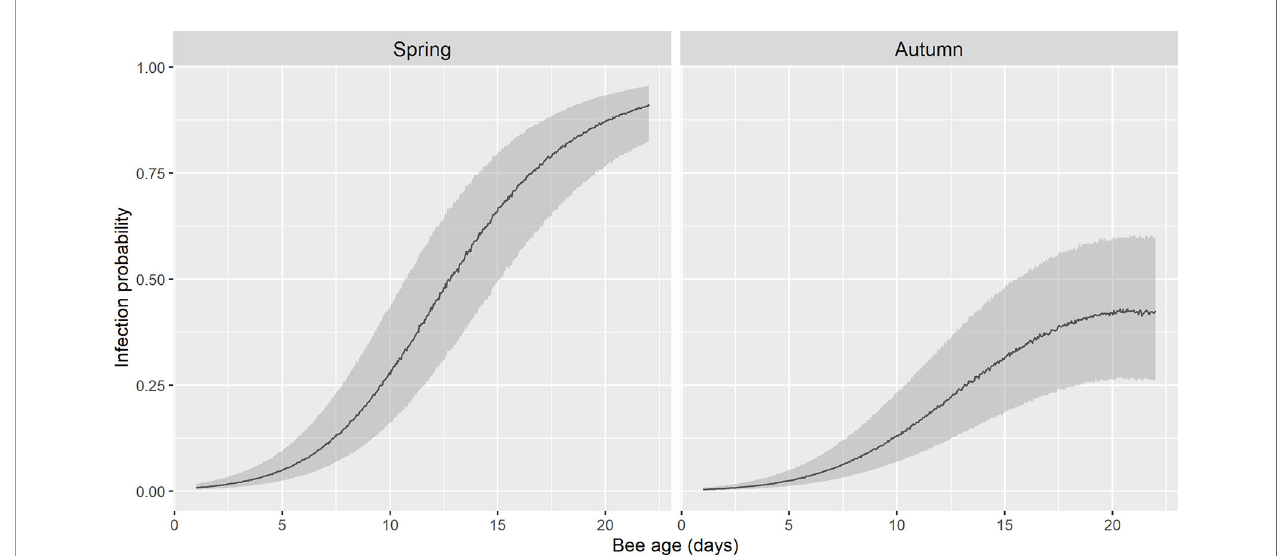
FIGURE 3 | Fitted probability of infection by N. ceranae in spring and autumn by GLMM. There is an exponential growth of infection in spring until the onset of foraging, whereas in autumn this probability remains lower. The shadow area represents 95% con fi dence